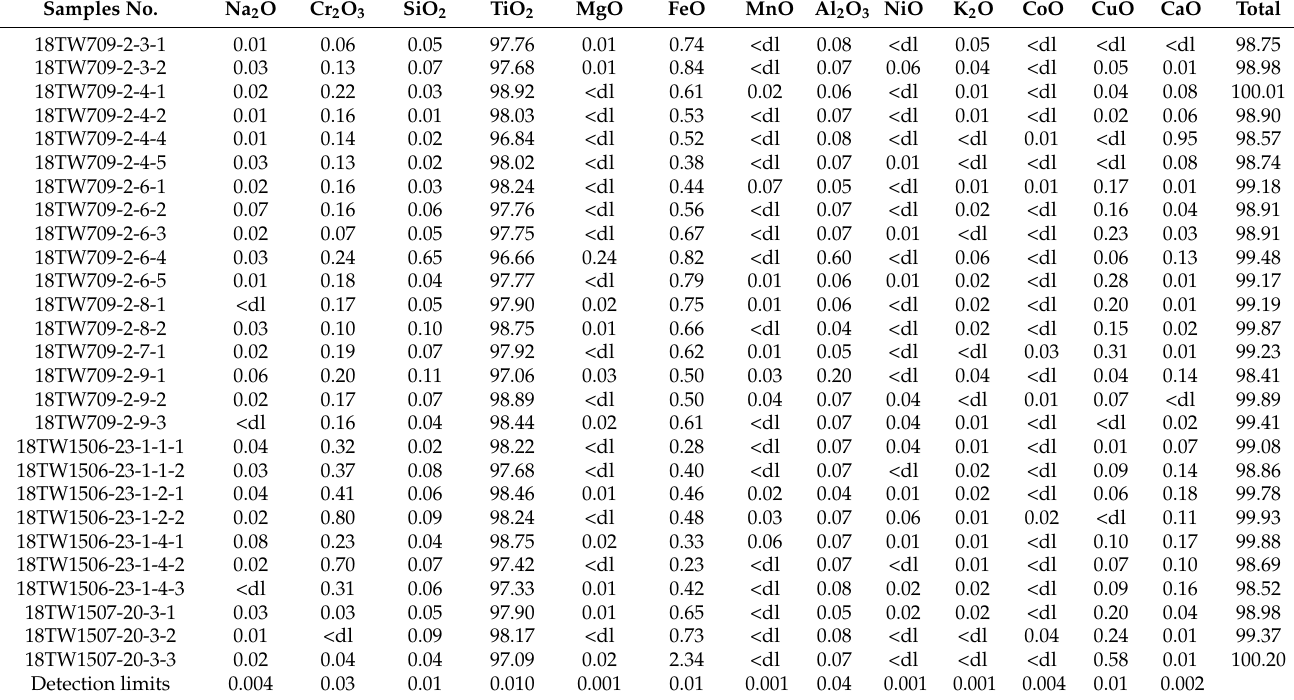
Table 1. Summary of the major element compositions of rutile in Tuwu (wt %). dl = detection limits. Samples